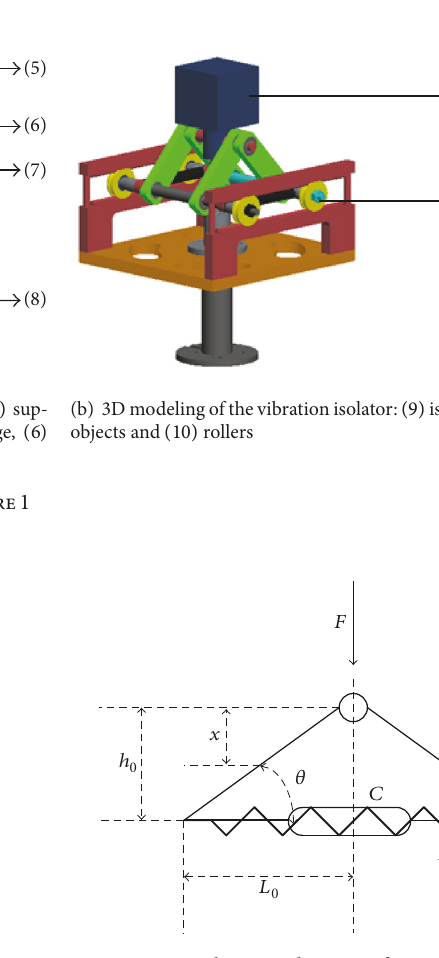
Figure 2: Schematic diagram of stress